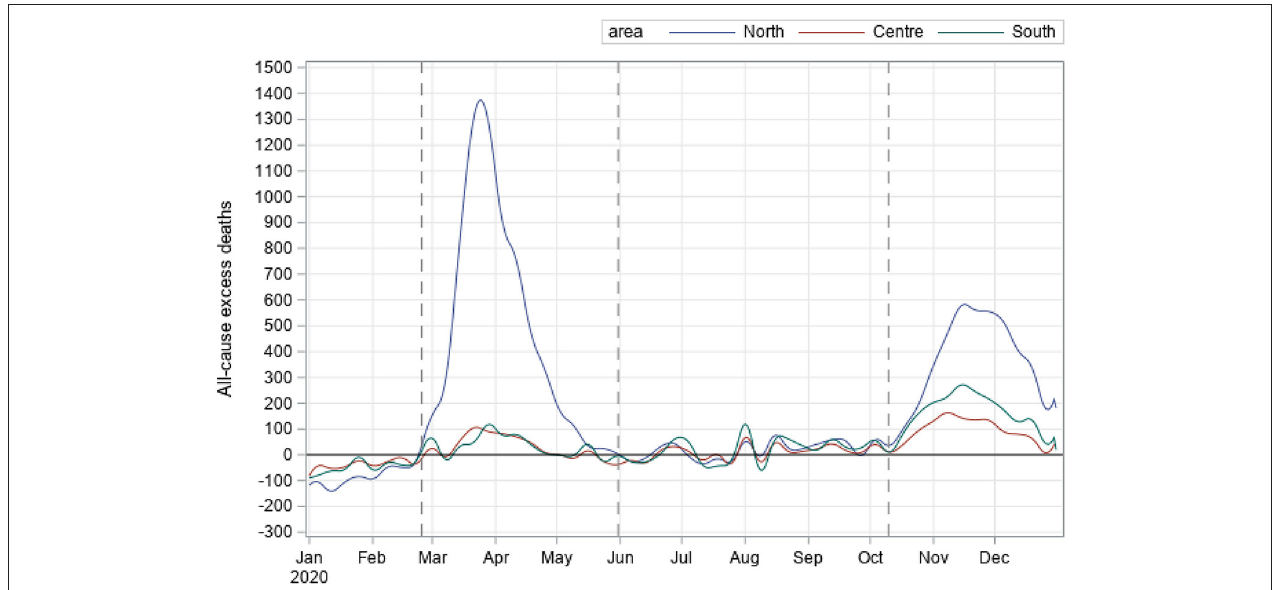
FIGURE 1 | All-cause excess deaths during the COVID-19 pandemic by geographical macro-area, Italy - year